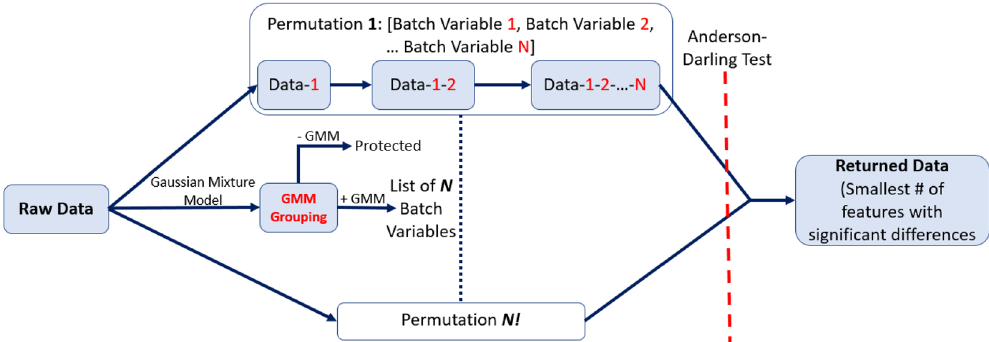
Figure 3. Workflow for the OPNested, OPNested + GMM, and OPNested − GMM ComBat implementations for sequential harmonization given two batch effects. Red denotes a batch effect, while the dash indicates that the data has been harmonized by a particular batch effect (i.e., Data-1 means the data has been harmonized by batch effect 1, Data-1-2 means Data-1 has been harmonized again by batch effect 2,